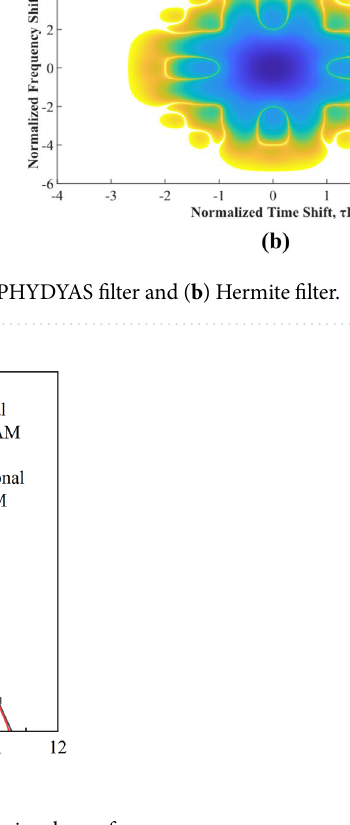
Figure 4. Simulated PAPR of different multi-carrier signal